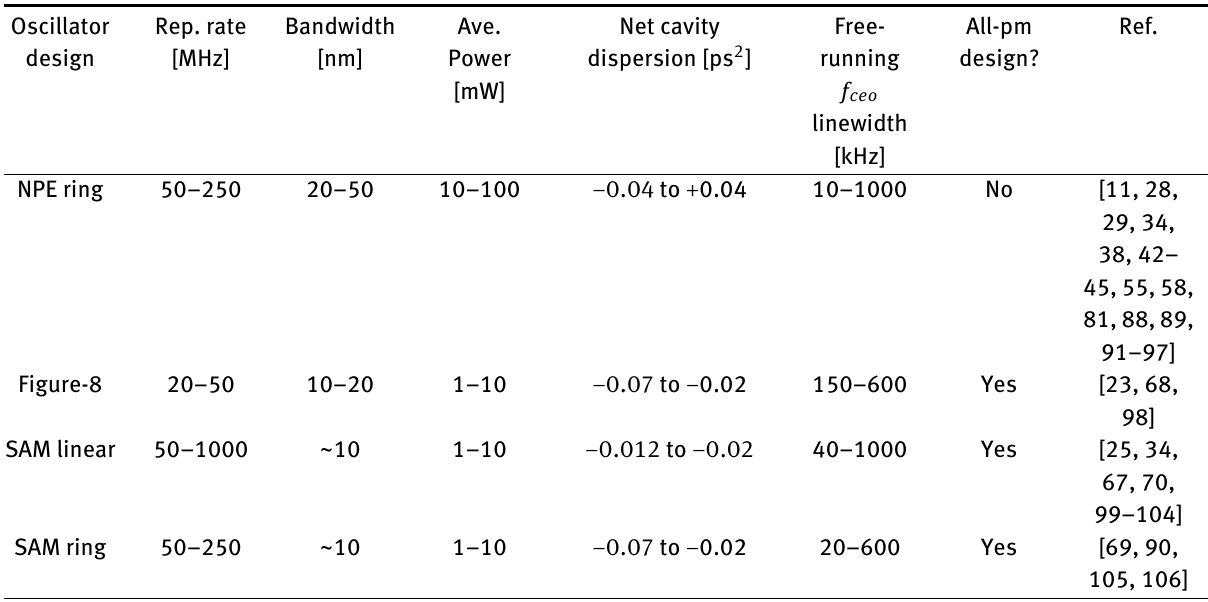
Table 1: Typical characteristics of demonstrated erbium fiber lasers used for stable frequency comb generation. Oscillator design